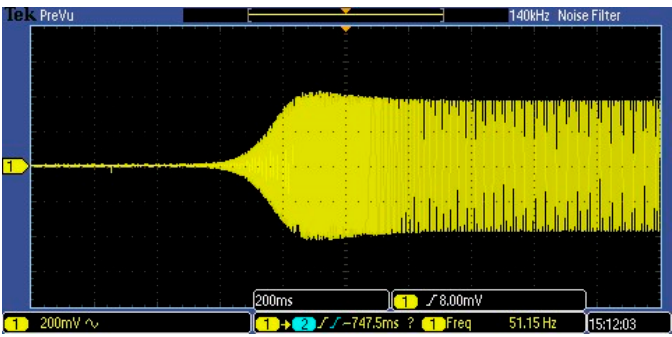
Figure 11. The start-up transient signal of the closed-loop system for the sensor.